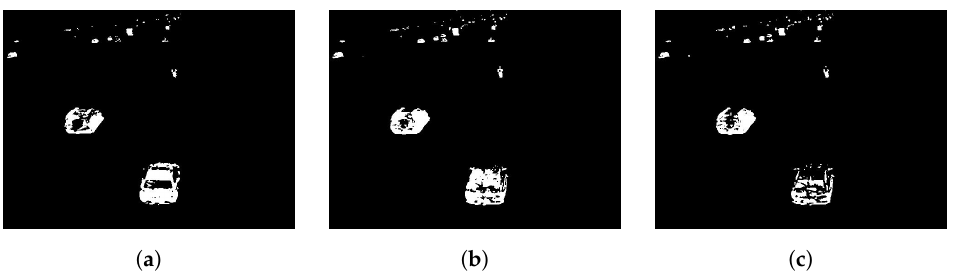
binary green ), and ( c ) blue mode 539